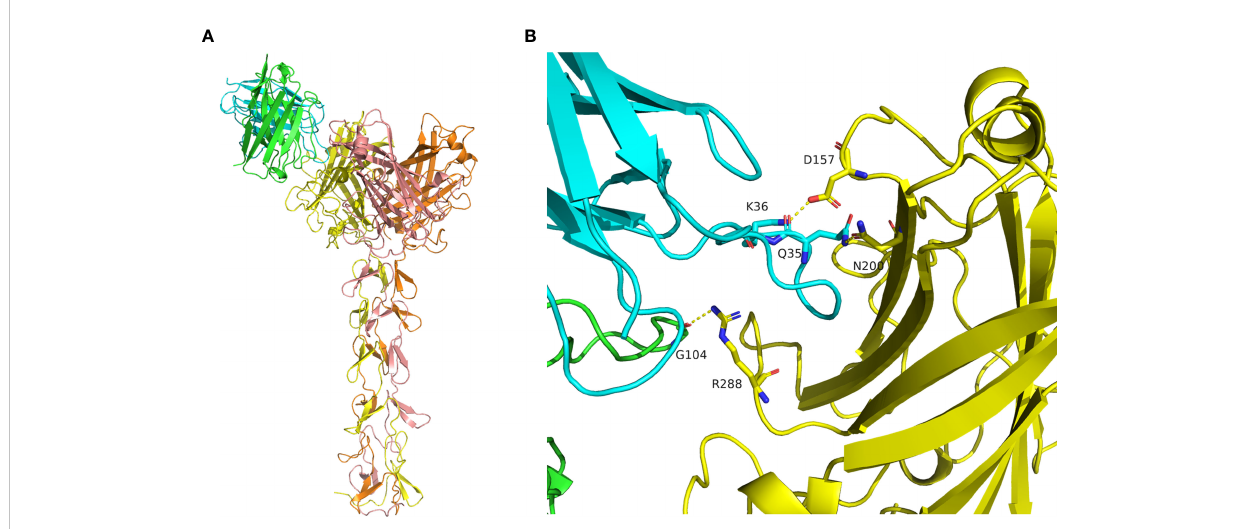
FIGURE 6 Molecular docking of mAb 9-8-h2 to the Fiber antigen. (A) Predicted structure of the antibody-antigen complex by HADDOCK3. The heavy chain is marked in green, and the light chain is marked in cyan. The antigen homotrimer is marked in yellow, orange, and salmon. (B) Binding mode of the antibody-antigen interaction surface.